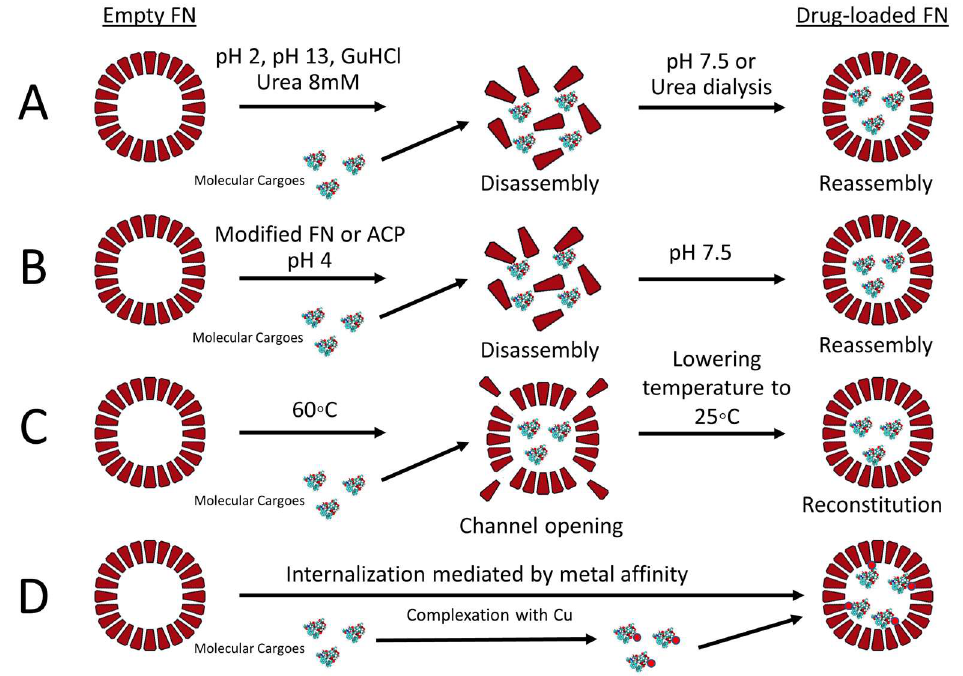
Figure 3. Biochemical strategies used to load different cargoes into FNs: ( A ) pH or urea-mediated disassembly–reassembly methodology; ( B ) modified ferritins or ACP can be utilized to disassemble FN at pH 4, and then pH 7.5 is used to reassemble FN; ( C ) high temperatures partially destabilize FN to allow channel openings with consequent drug loading, and then lowering the temperature can slowly reconstitute the natural conformation of FN; ( D ) molecular cargoes can be complexed with Cu(II) or other metal ions which have a high affinity for the internal cavity of FN. This methodology permits the loading of hydrophobic molecules with some limitations.